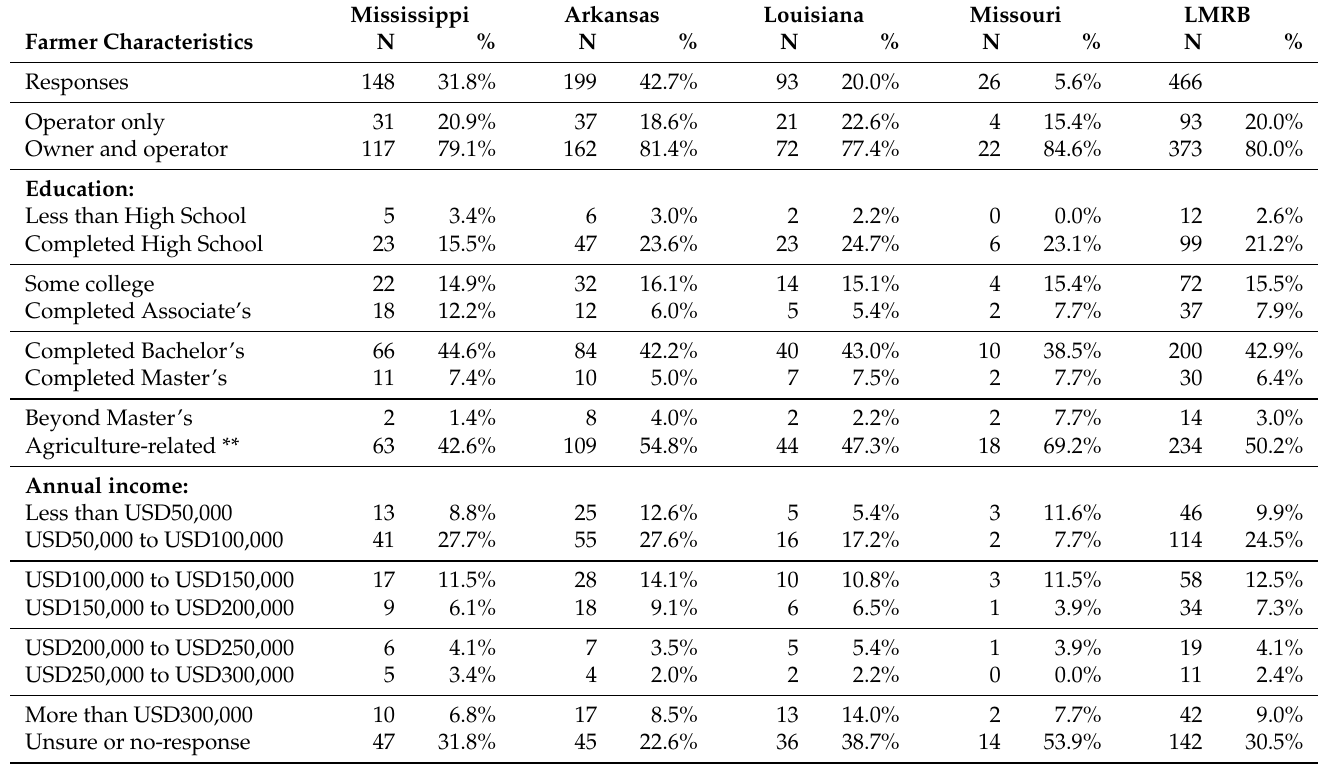
Table 1. Summary statistic of farmer characteristics from an irrigation survey conducted in the Lower Mississippi River Basin (LMRB) in